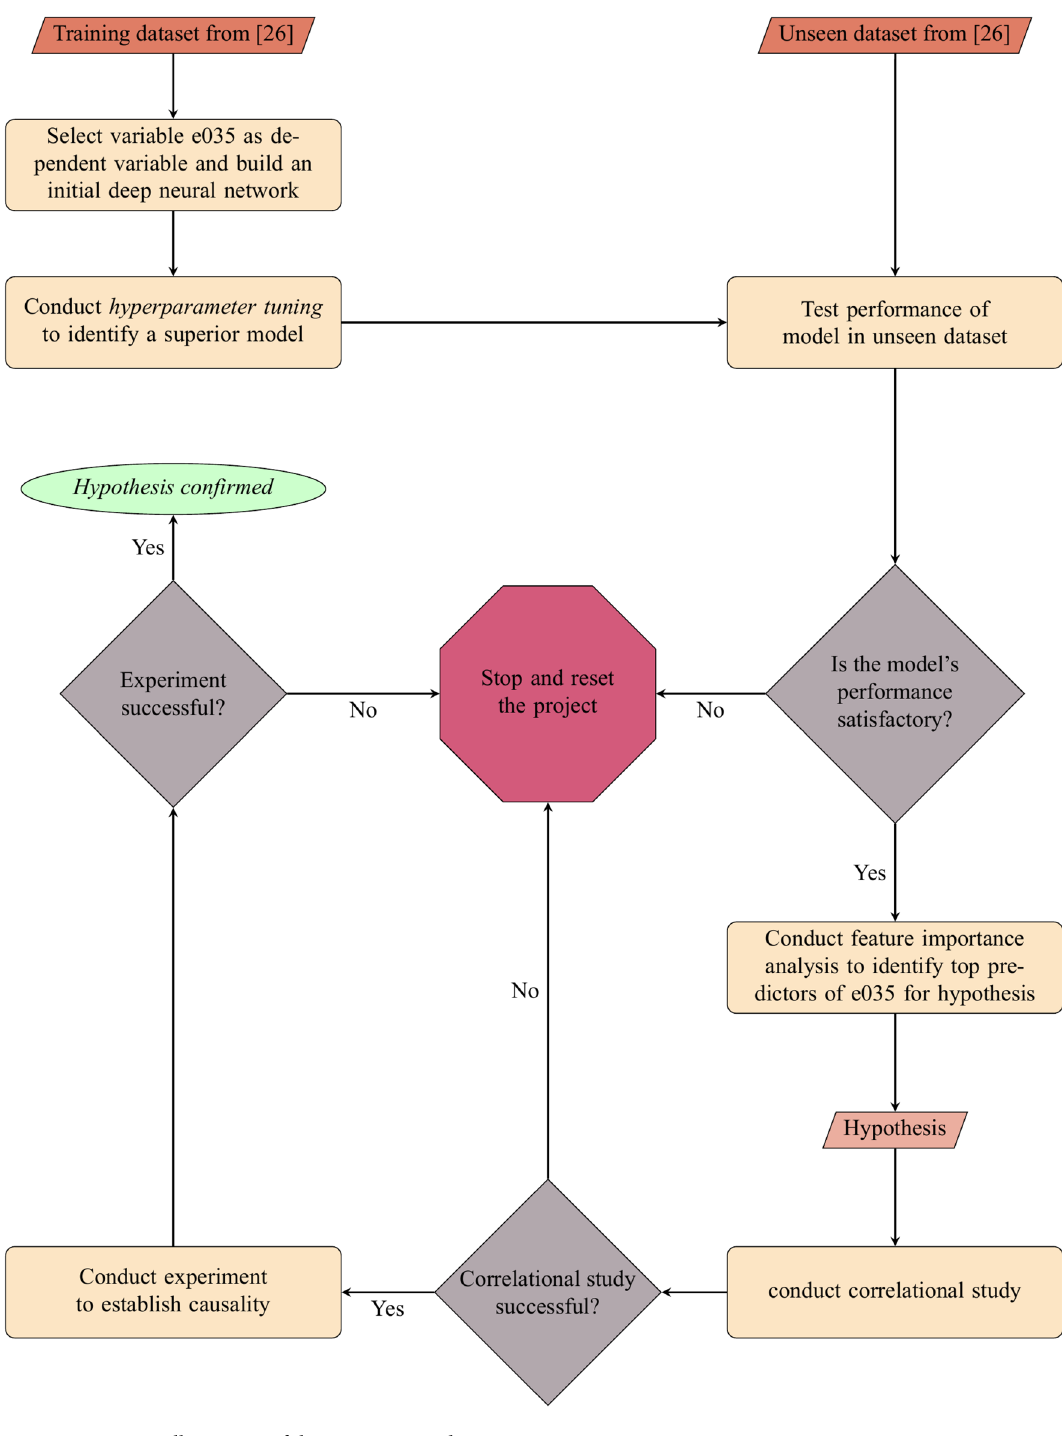
Figure 1. Illustration of the project